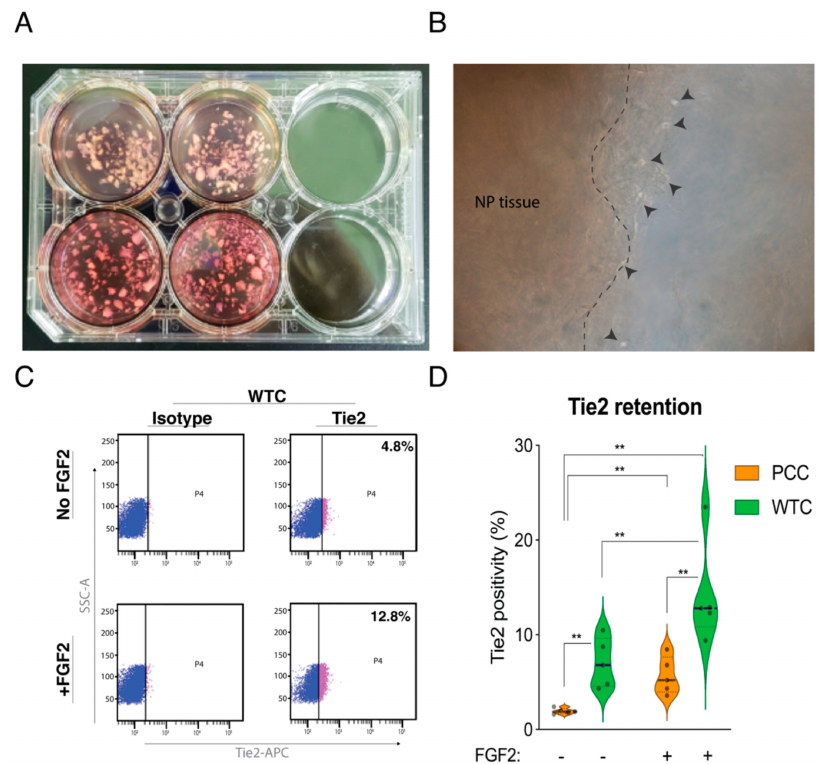
Figure 1. Comparison of primary cell culture (PCC) and whole tissue culture (WTC) methods. ( A ) Human nucleus pulposus (NP) tissue is fragmented into 3–5 mm pieces and suspended in culture medium. ( B ) Following two weeks of culture, cell division and proliferation occurred in tissue without attaching or stretching to the plate. ( C ) Representation of flow cytometry analysis on WTC and PCC NP cells, supplemented with or without FGF2. Gating occurred by on isotype controls [23]. ( D ) Flow cytometry quantitative data ( n = 5) assessing the fraction of Tie2-expressing NP cell, as median (bar) and quartiles (dotted lines). ** p <